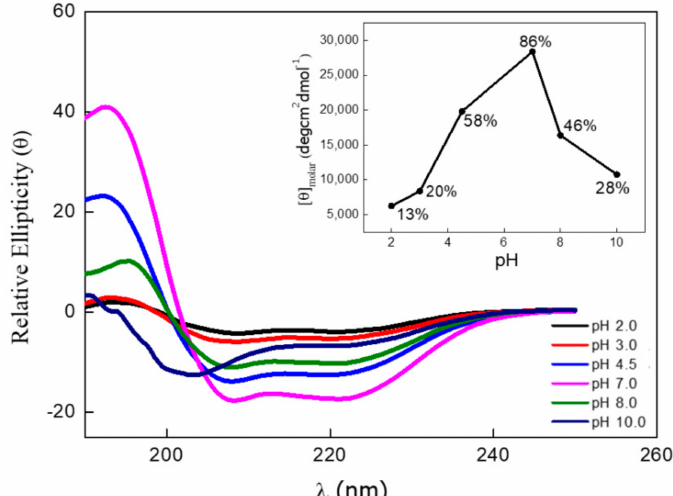
Figure 4. Circular dichroism spectra for AnxA6 (2 µ g · mL − 1 ) at different pH values. Insertion: Relative molar ellipticity as a function of pH variation with the respective percentage estimates of α -helix structures. Black—pH 2.0 (13%); Red—pH 3.0 (20%); Azul—pH 4.0 (58%); Pink—pH 6.5 (86%); Green—pH 8.0 (46%); and Purple—pH 10.0